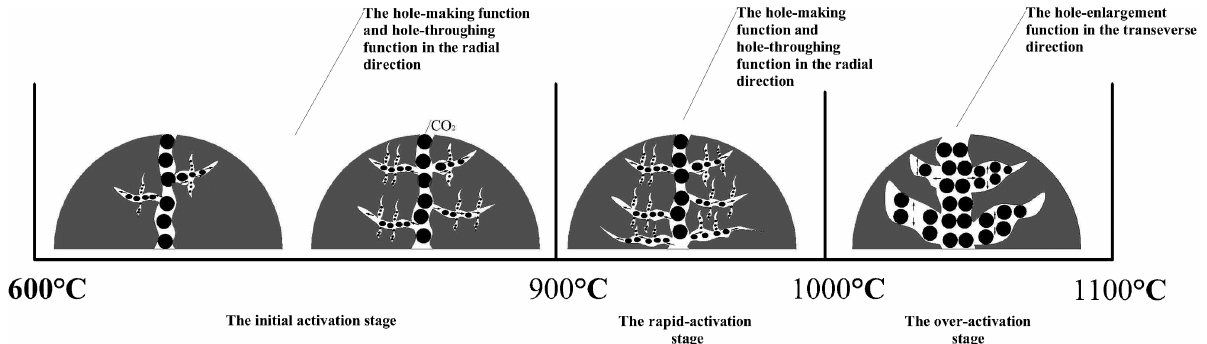
Figure 7: The variation of pore structure in CO